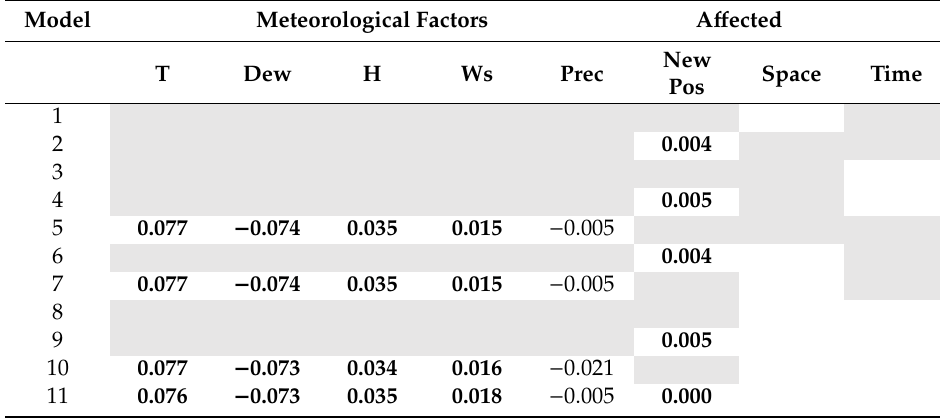
Table 2. Significant variable coe ffi cients of 11 fitted models (for O 3 ).